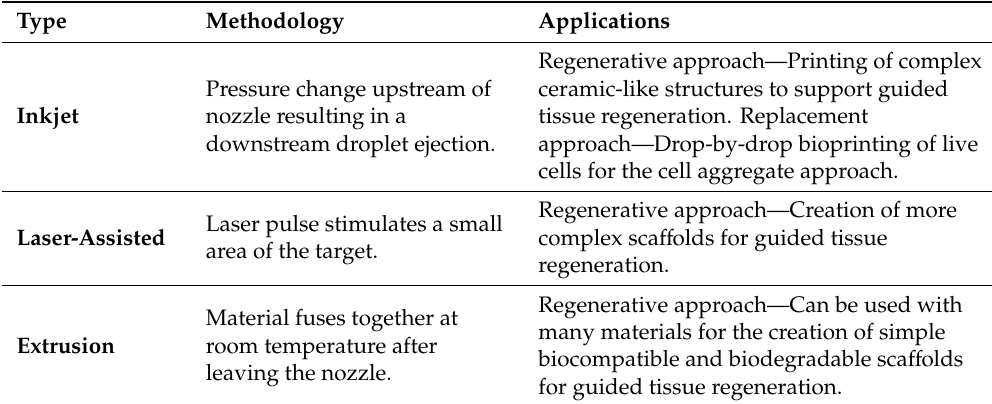
Table 1. Summary of 3D printing